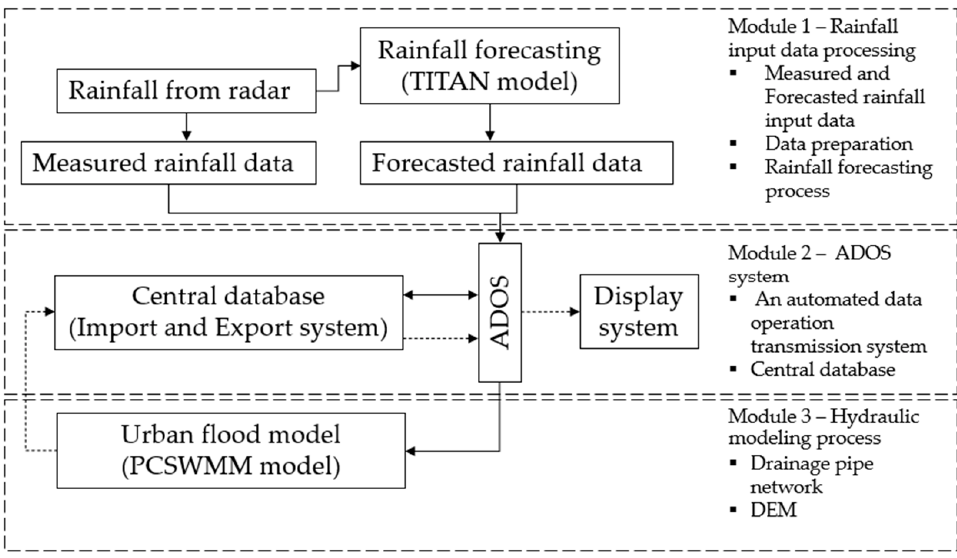
Figure 3. The framework of the real-time flood forecasting system (RTFlood system). It contains three modules, i.e., rainfall input data processing, automated data operation system (ADOS), and hydraulic model processing.